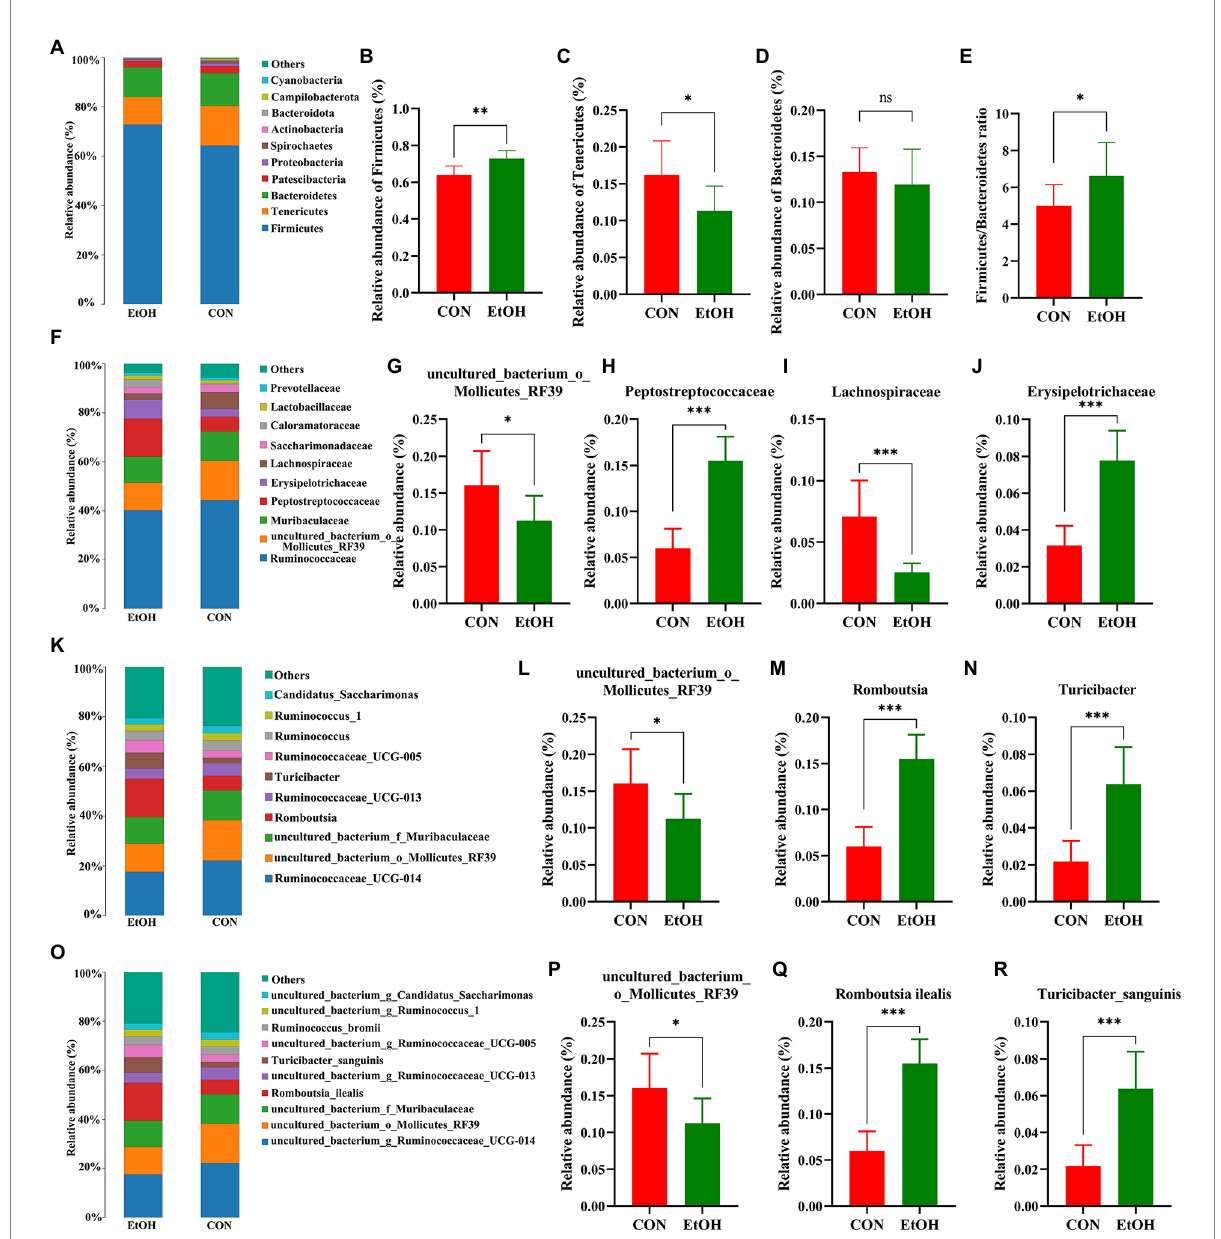
FIGURE 4 Chronic intermittent ethanol voluntary drinking alters the composition of gut microbiota in rats. Histogram of top 10 relative abundance at different level. The relative abundance and the main bacterial genera between the two groups with Wilcoxon rank-sum test at the phylum (A–E) , family (F–J) , genus (K–N) , and species (O–R) level in the fecal samples. Values are presented as the mean ± SD ( n = 8 per group), * p < 0.05, ** p < 0.01, *** p <